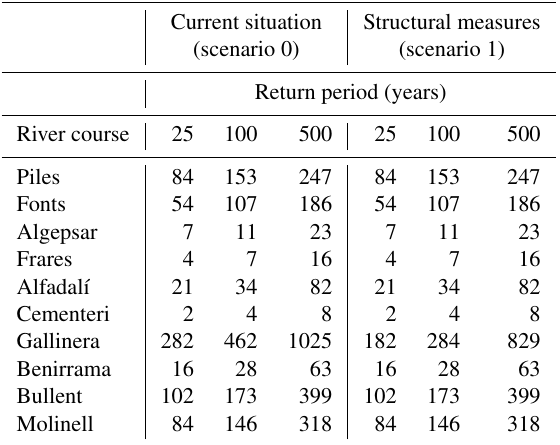
Table 3. Simulated peak flow discharges per river course (SOBEK model) (m 3 s − 1